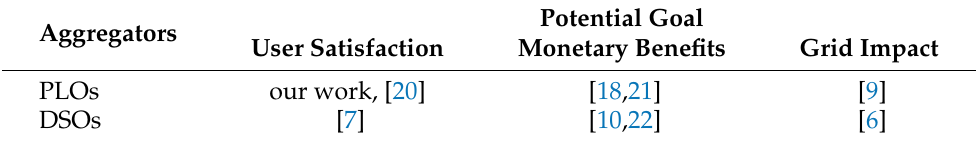
Table 1. Classification of related